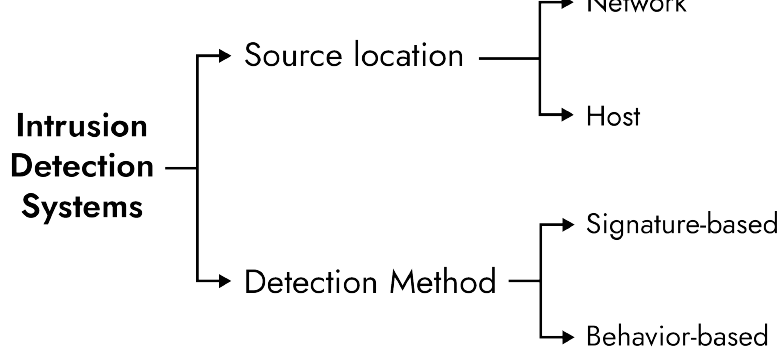
Figure 1. Intrusion detection systems